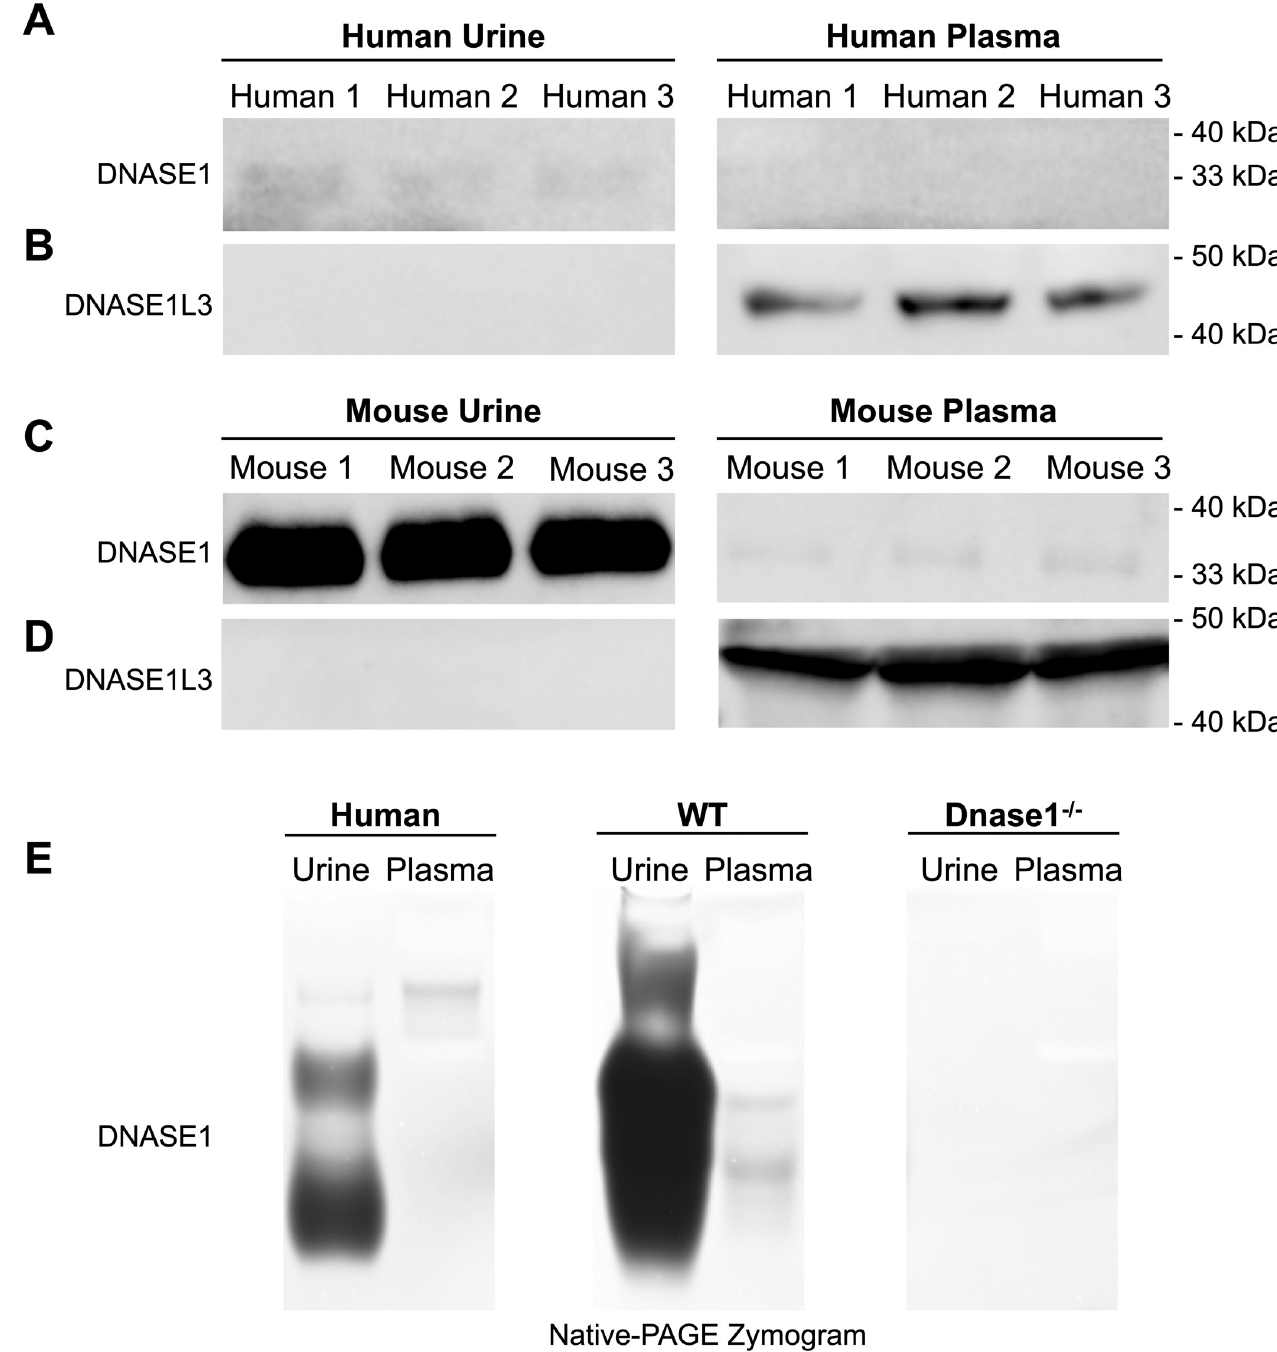
Fig 8. Western blot and zymogram analysis of DNASE1 and DNASE1L3 in urine and plasma samples from healthy human subjects and C57BL/6 mice. Urine (left three) and plasma (right three) samples (2 μ l/lane) from three human subjects were subjected to SDS-PAGE and then immunoblotted with anti- DNASE1 antibody (Abcam ab113241) (A) and anti-DNASE1L3 antibody (Abcam ab152118) (B). The same western blot experiment was performed for murine urine (left three) and plasma (right three) samples against anti-DNASE1 antibody (Abcam ab113241) (C) and anti-DNASE1L3 antibody (Abcam ab152118) (D). Urine and plasma samples (2 μ l/lane) from human subjects and mice were loaded on the native PAGE gel containing plasmid DNA (pcDNA3.1 Invitrogen) (E). Bands represent the existence of nuclease activity to digest plasmid DNA. Samples from Dnase1 -/- mice (right) serve as a control. Molecular weight markers (Bio-platform BP106) were used to estimate the sizes of the respective proteins in the immunoblotting. Chemiluminescence detection and gel imaging were performed using ChemiDoc MP Imaging Systems (Bio-Rad Laboratories). The experiments were repeated three times, and one representative experiment with three biological replicates was shown in western blot and